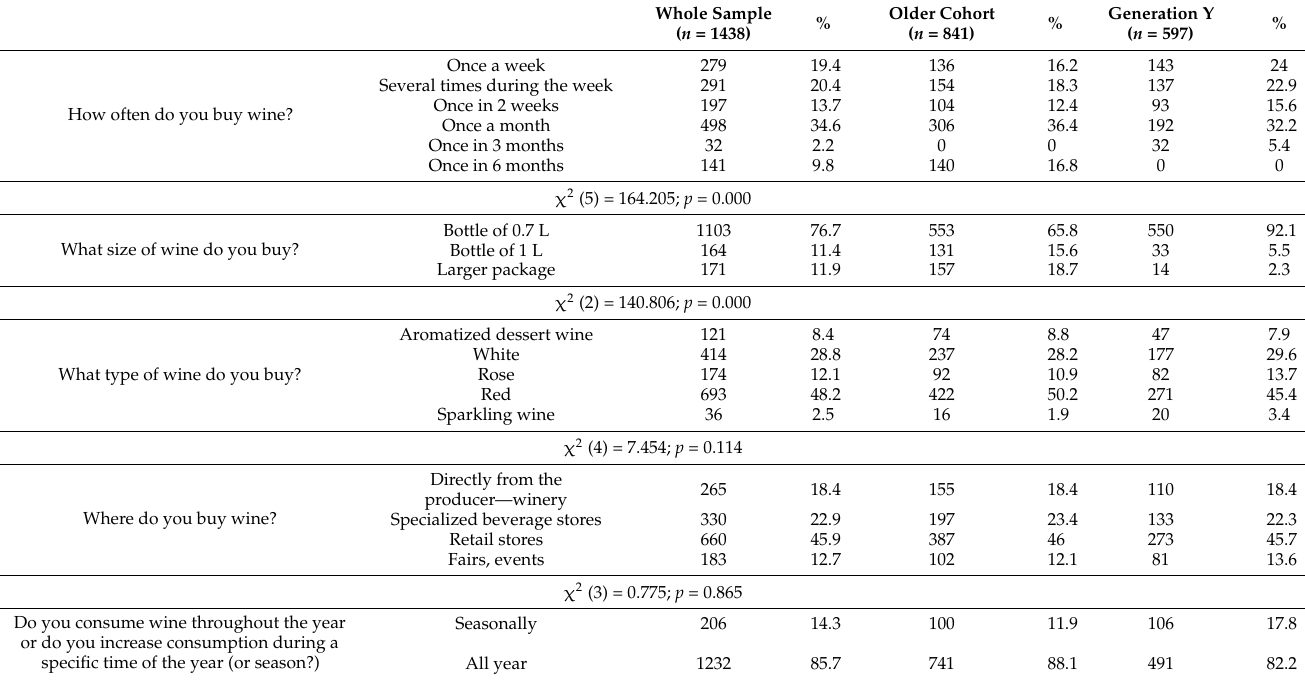
Table 2. Purchase patterns of wine